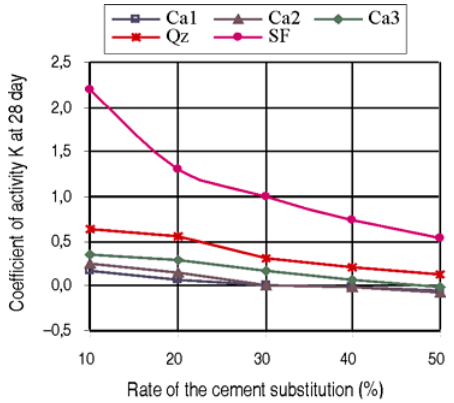
Fig 9. Evaluation of the coefficient of activity in 28 days, calculated on the basis of the predictive model of Feret according to the cement substitution